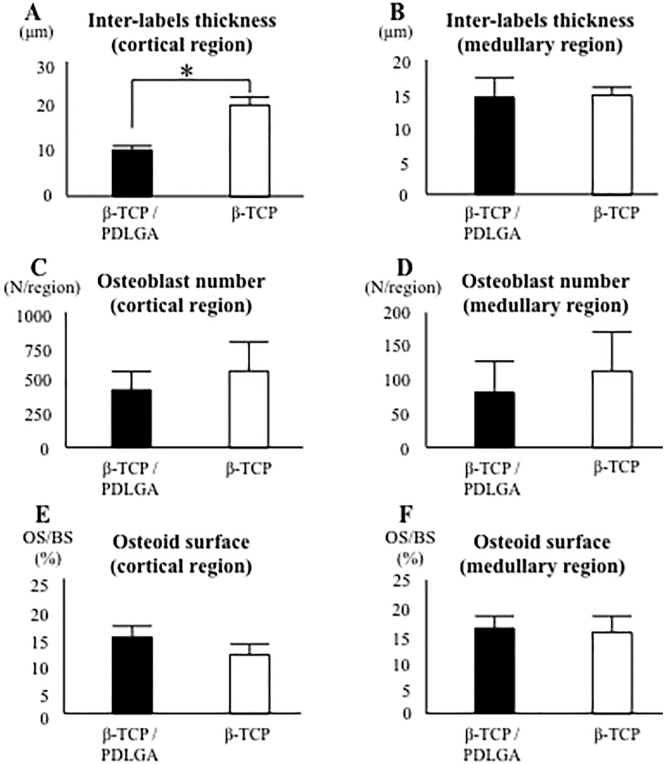
Bone formation ability, osteoblast number, and osteoid surface. Distance between double labels at (A) cortical region and (B) medullary regions. Osteoblast numbers at (C) cortical region and (D) medullary region. Osteoid surface/bone surface (OS/BS: %) at (E) cortical region and (F) medullary region. *: p < 0.05 by Mann-Whitney U test.